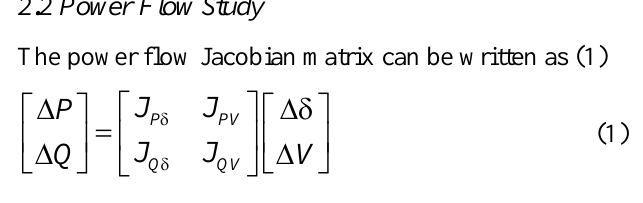
Fig. 2. Control structure at inverter’s end of multi-infeed HVDC